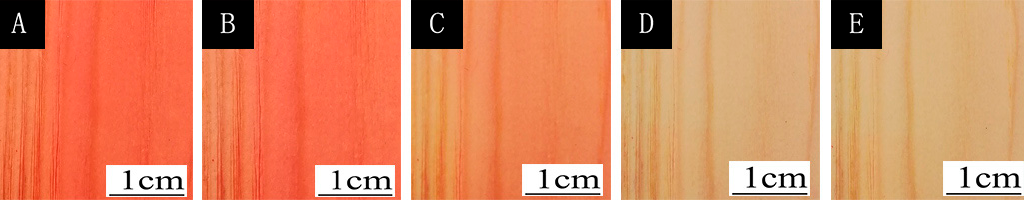
Figure 3. Image of of the finish film with 15.0% thermochromic ink changing with temperature : ( A ) 20 ◦ C, ( B ) 32 ◦ C, ( C ) 34 ◦ C, ( D ) 36 ◦ C, ( E ) 40 ◦